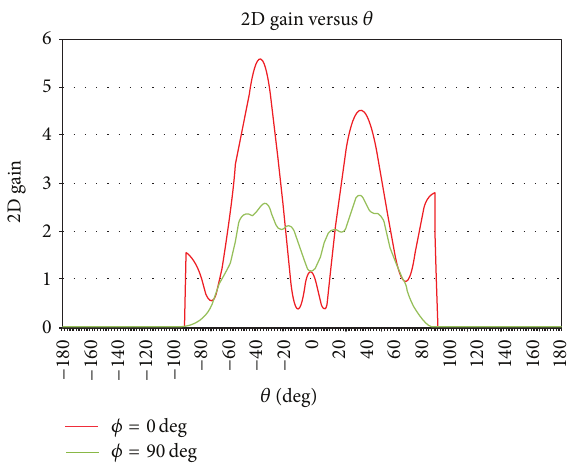
Figure 22: 2D gain of the CRA for the fourth iteration at 8.44 GHz.